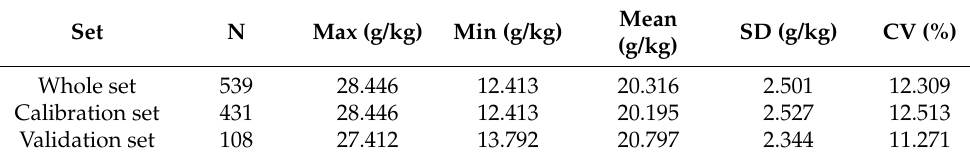
Table 2. Statistical description of SOM content.